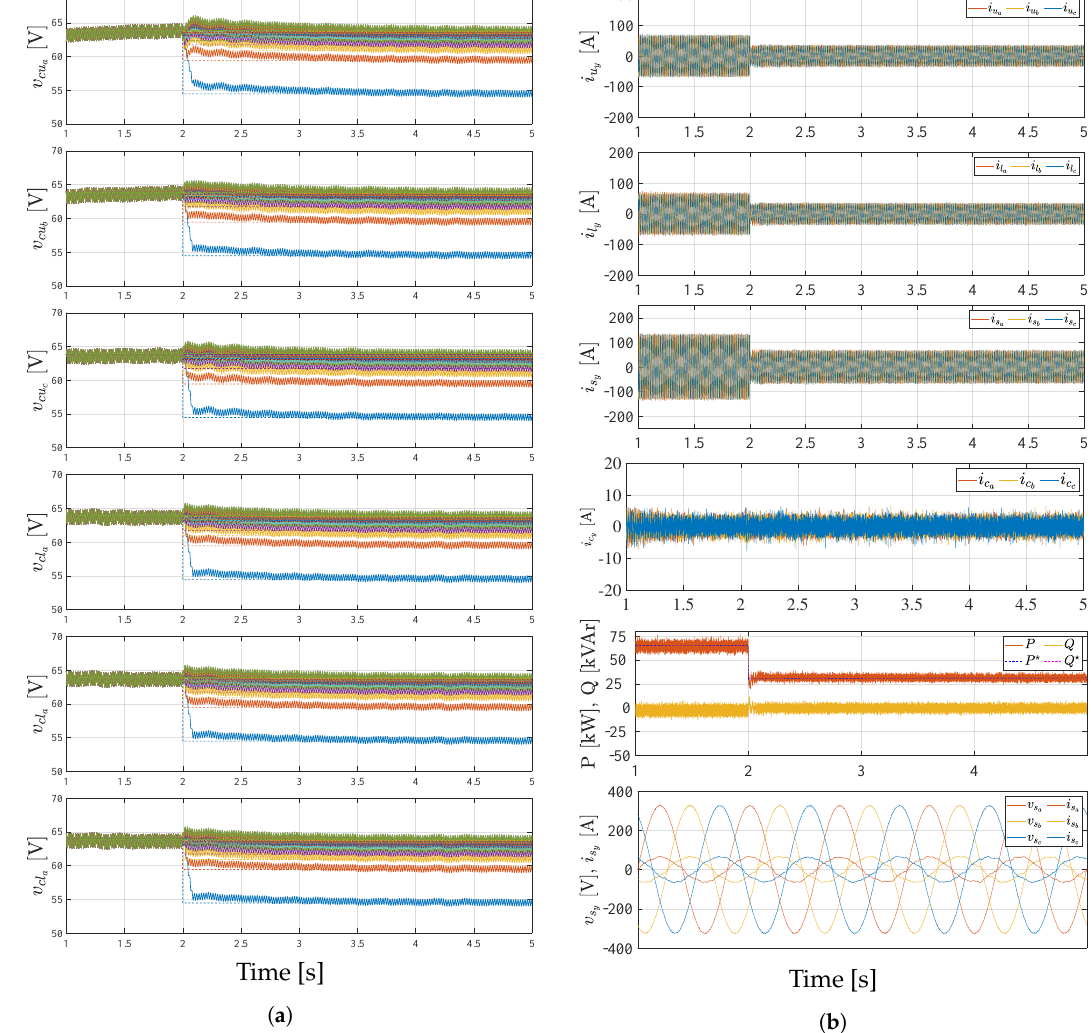
Figure 8. Simulation results for scenario 2: ( a ) Capacitor voltages for all the sub-modules in an arm of the MMC for all three phases. From the top, upper arm phase “a”, upper arm phase “b”, upper arm phase “c”, lower arm phase “a”, lower arm phase “b”, and lower arm phase “c”, respectively. [ A ] , i l [ A ] ), output currents ( i s [ A ] ), circulating currents ( b ) The upper and lower arm currents ( i u y y y [ A ] ( i c y = a, b, c), the active and reactive power injected to the grid ( P [ kW ] , Q [ kVAr ] ), and the plot y ∀ [ V ] [ A ] ) for 100 ms duration shown the voltages ( v s y = a, b, c) at PCC and the phase currents ( i s y y ∀ between 4.9 s to 5 s, y = a, b, ∀